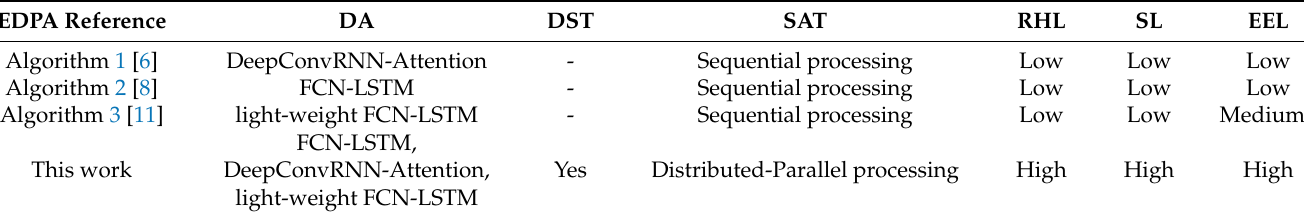
Table 2. A summary of the related EDPA